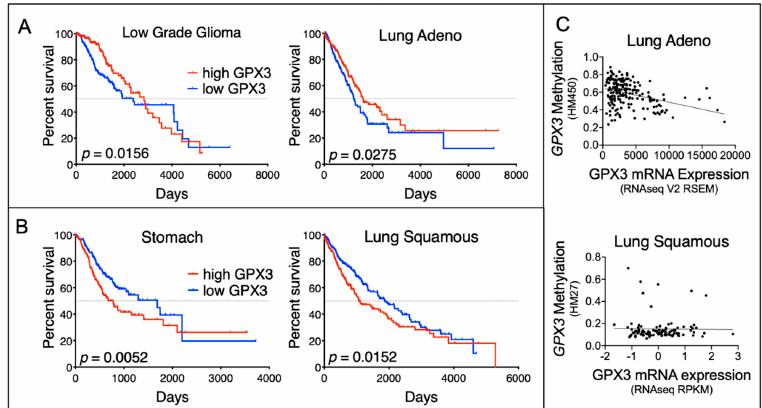
Figure 3. The dichotomous role of GPx3 in cancer is illustrated by the divergent associations between GPx3 expression and patient survival. ( A ) Low-grade glioma and lung adenocarcinomas are two examples where low GPx3 predicts worse overall patient survival. ( B ) Conversely, high GPx3 predicts worse overall patient survival in stomach and lung squamous cell carcinomas. ( C ) In cancers where low GPx3expressionisassociatedwithpooroutcome, suchaslungadenocarcinoma, GPx3mRNAexpression (RNA-sequencing by expectation maximization [RSEM] values) correlates negatively with methylation